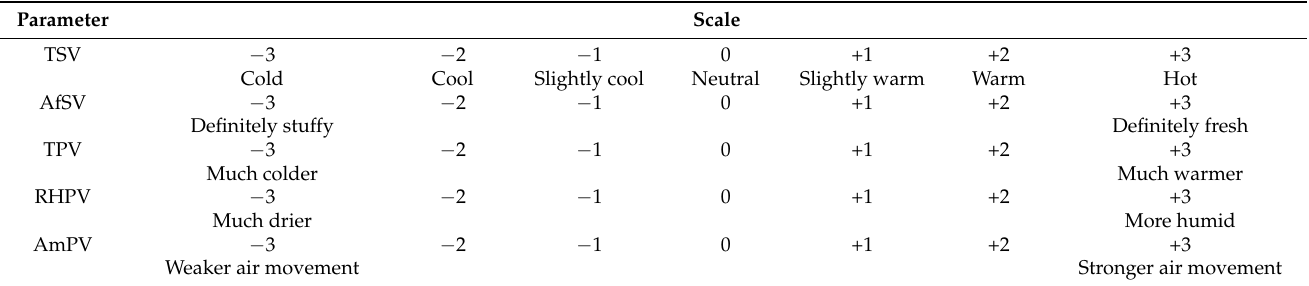
Table 3. Thermal and freshness sensation, thermal, humid and air movement preferences scales used in the questionnaire. Parameter